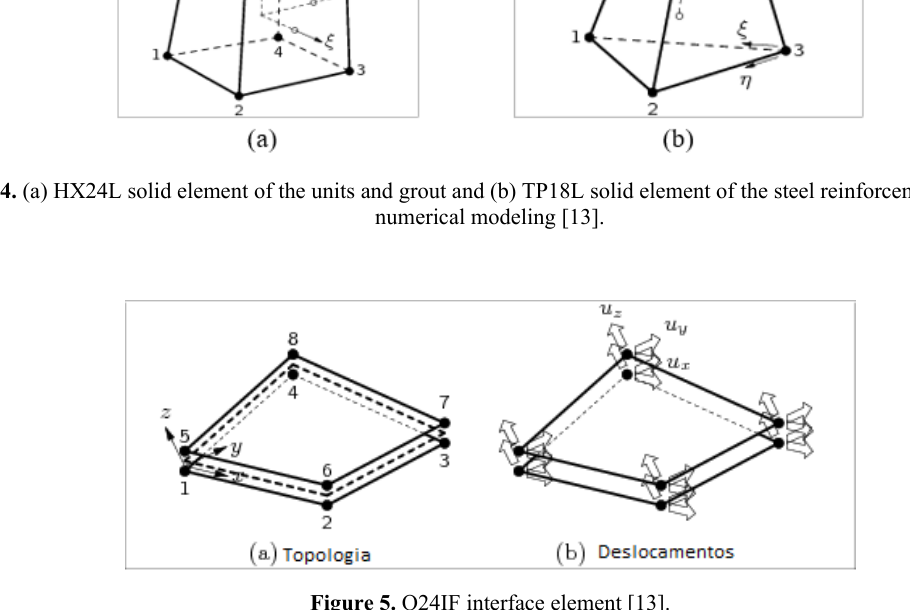
Figure 5. Q24IF interface element [13].